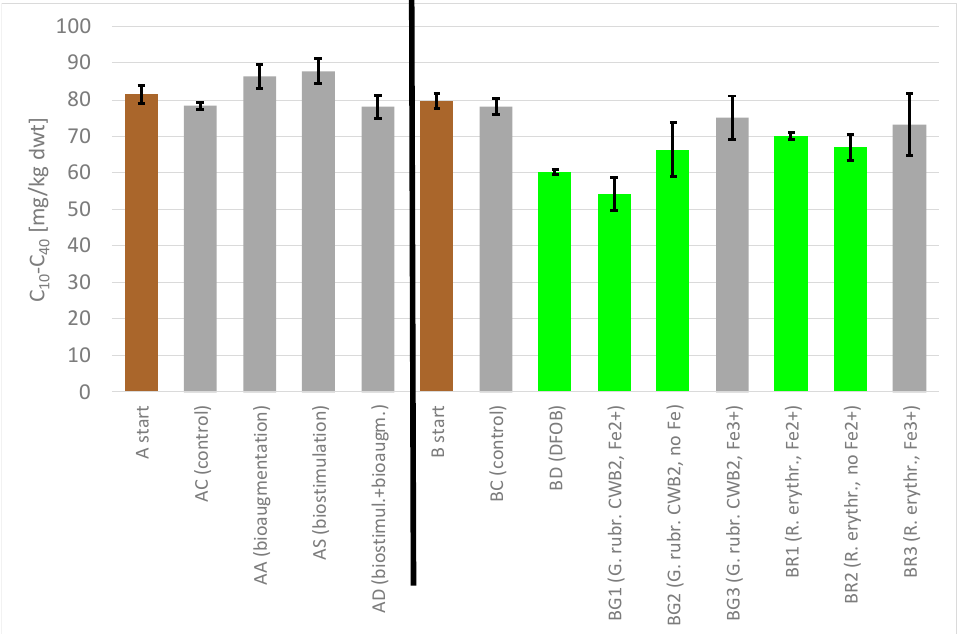
Figure 1. Aliphatic hydrocarbon concentrations in both experiments. Brown colour indicates initial values, light-green colour indicates significant decrease compared to control (Tukey’s pairwise post-hoc tests, p < 0.05).